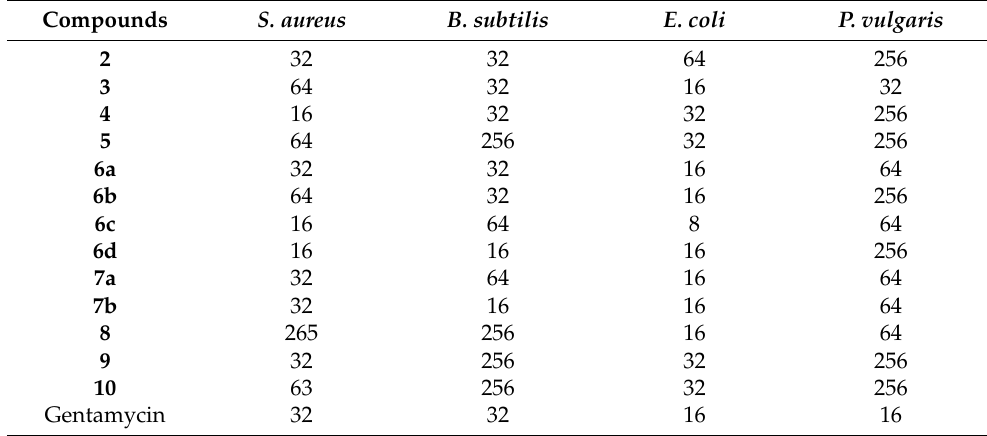
Table 2. The minimal inhibitory concentration (MIC: µ g/mL) of compounds 2 – 10 .